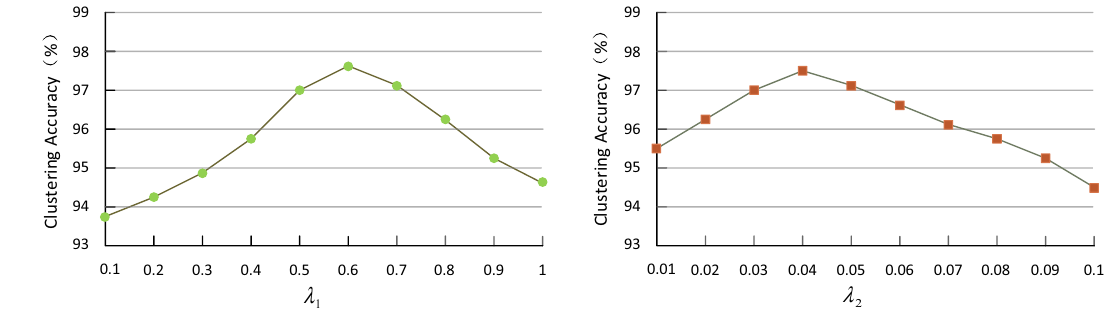
Figure 7. Comparison of the accuracy of different parameter values (cid:31) 1 and (cid:31) 2